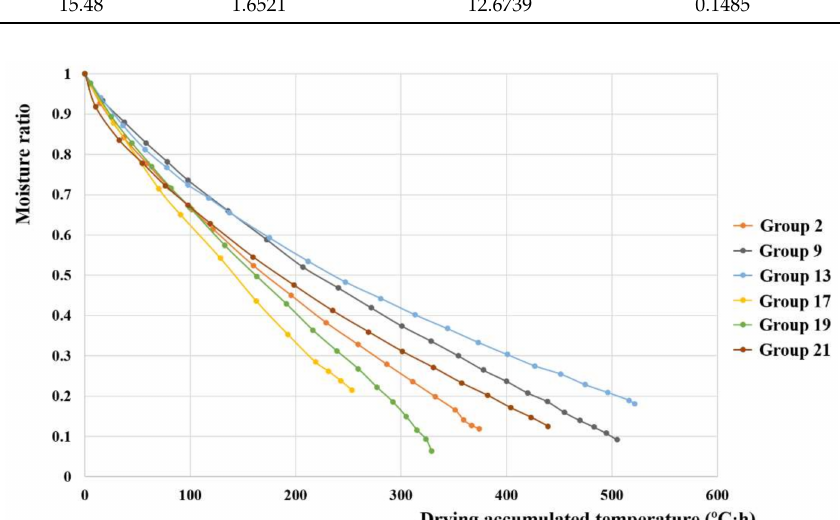
Figure 2. Drying accumulated temperature versus moisture